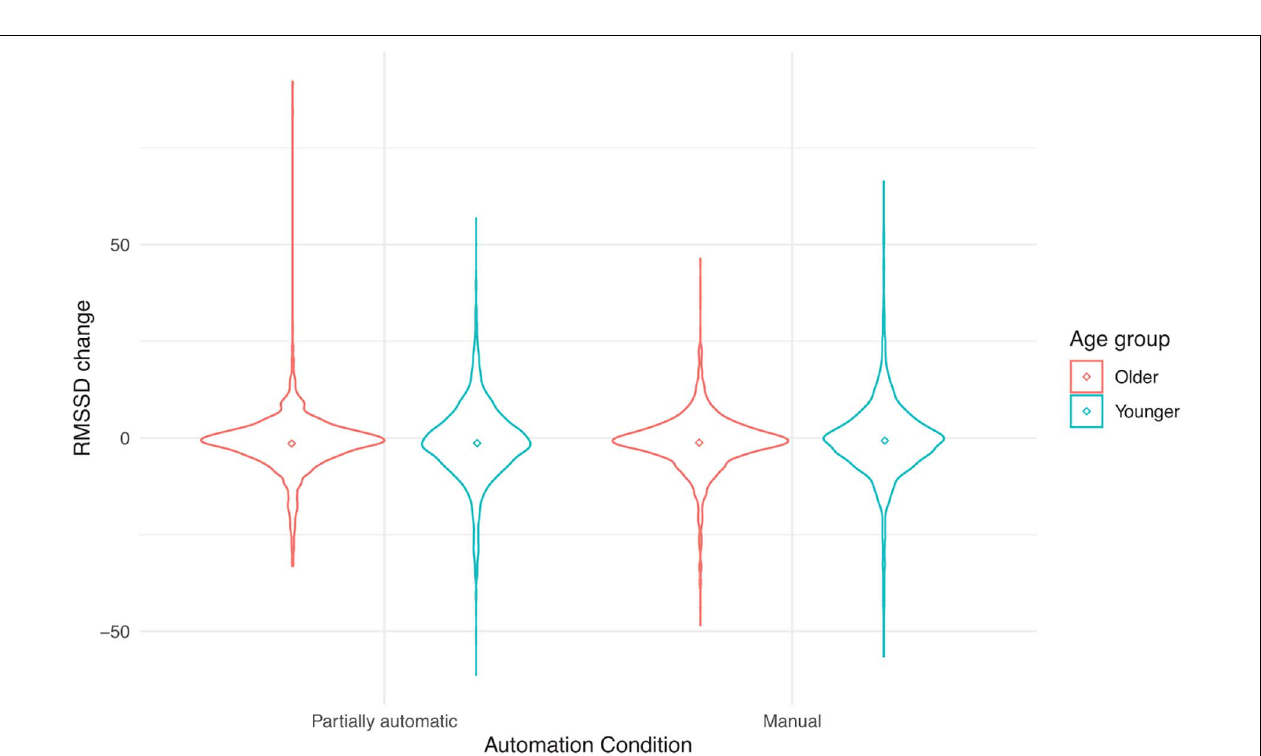
FIGURE 2 | RMSSD change from baseline as a function of automation (manual and partial automation) and age (younger or older).